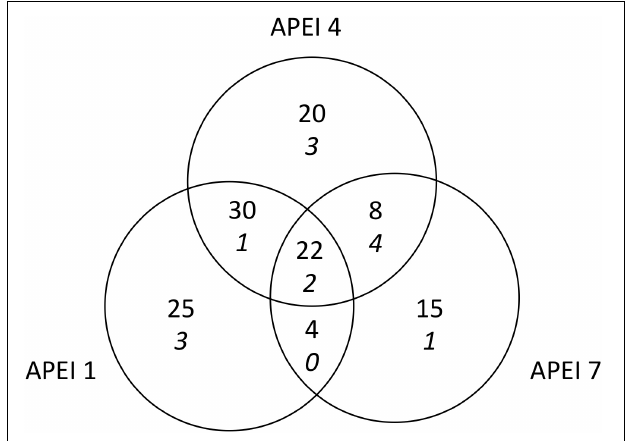
FIGURE 5 | Shared megafaunal morphotypes between APEIs on the abyssal plain for both invertebrates (plain font) and highly mobile scavengers and predators